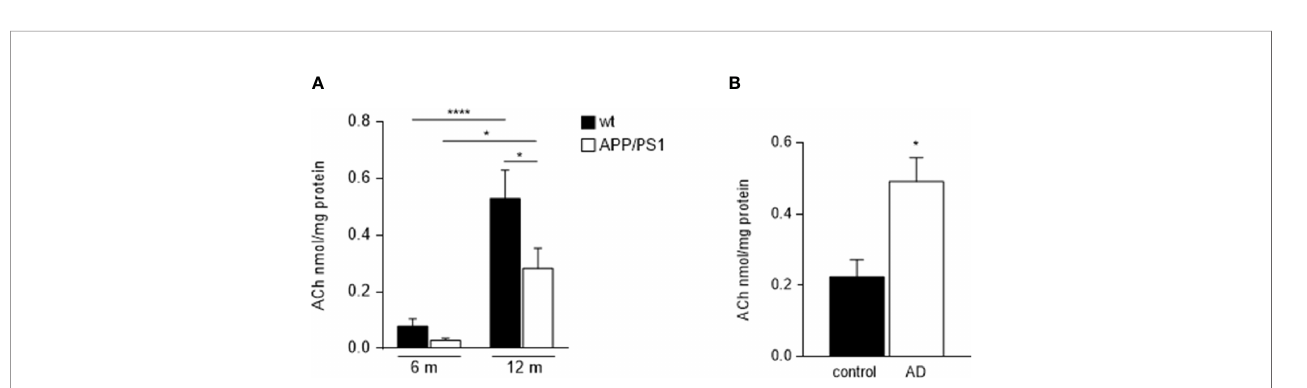
FIGURE 4 | Ach levels in submandibular glands from APP/PS1 mice and AD patients. (A) Salivary gland ACh levels increased with ageing in both, APP/PS1 and WT mice. However, APP/PS1 mice showed lower ACh levels in their submandibular glands compared to WT mice, signi fi cantly at 12-month-old ( n = 9-10, per group). (B) There were higher levels of ACh in submandibular glands from AD patients compared with control subjects ( n = 8-9, per group). Data are represented as mean ± SEM. Differences between groups were assessed using the ANOVA and Tukey ’ s test for mice samples, and the Mann-Whitney test for human samples. *p < 0.05; ****p < 0.0001.